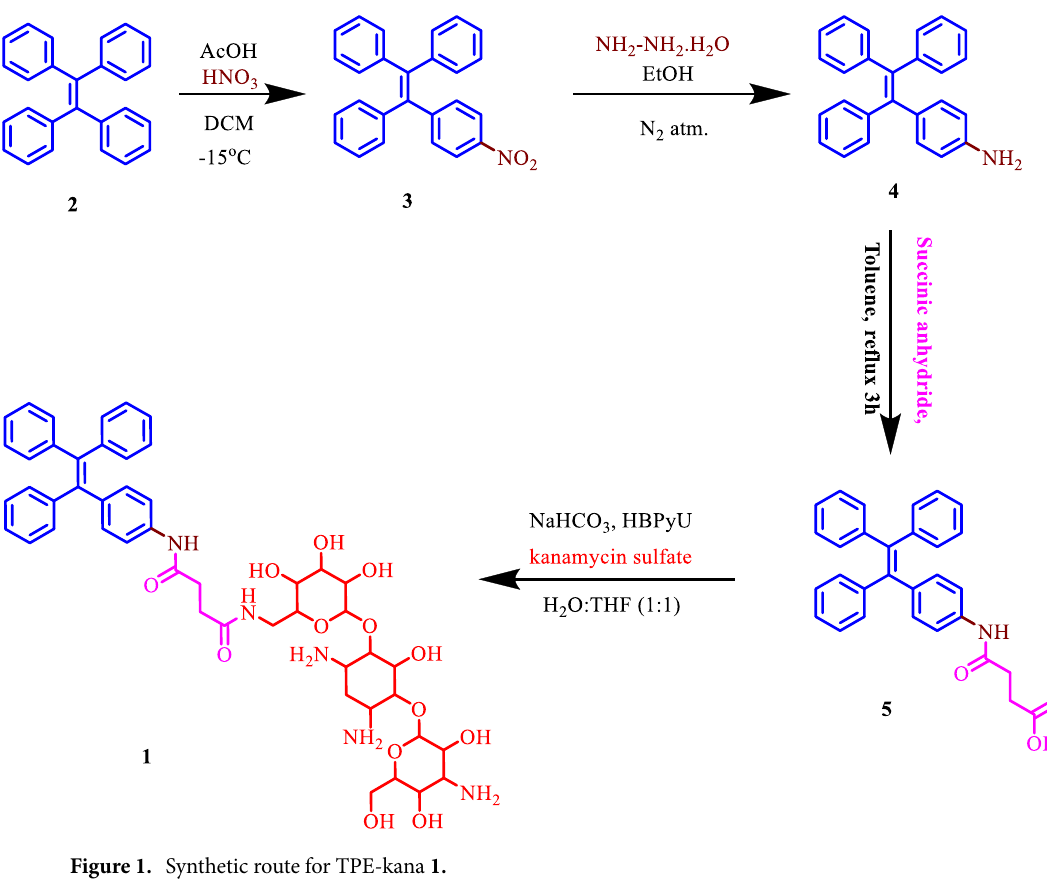
Fig. 1. The (2-(4-nitrophenyl-1,1,2-triyl)tribenzene 3 was synthesized in the first step by mono-nitration of TPE 1 . The 4-(1,2,2-triphenylvinyl)aniline 4 was obtained by reducing compound 3 using hydrazine hydrate. The